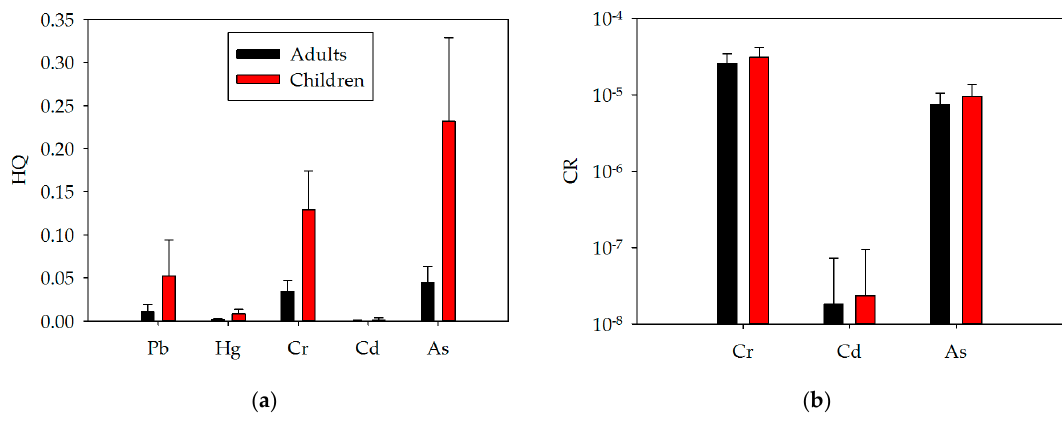
Figure 4. Hazard Quotients (HQs) ( a ) and carcinogenic risks (CRs) ( b ) of the tested metals.